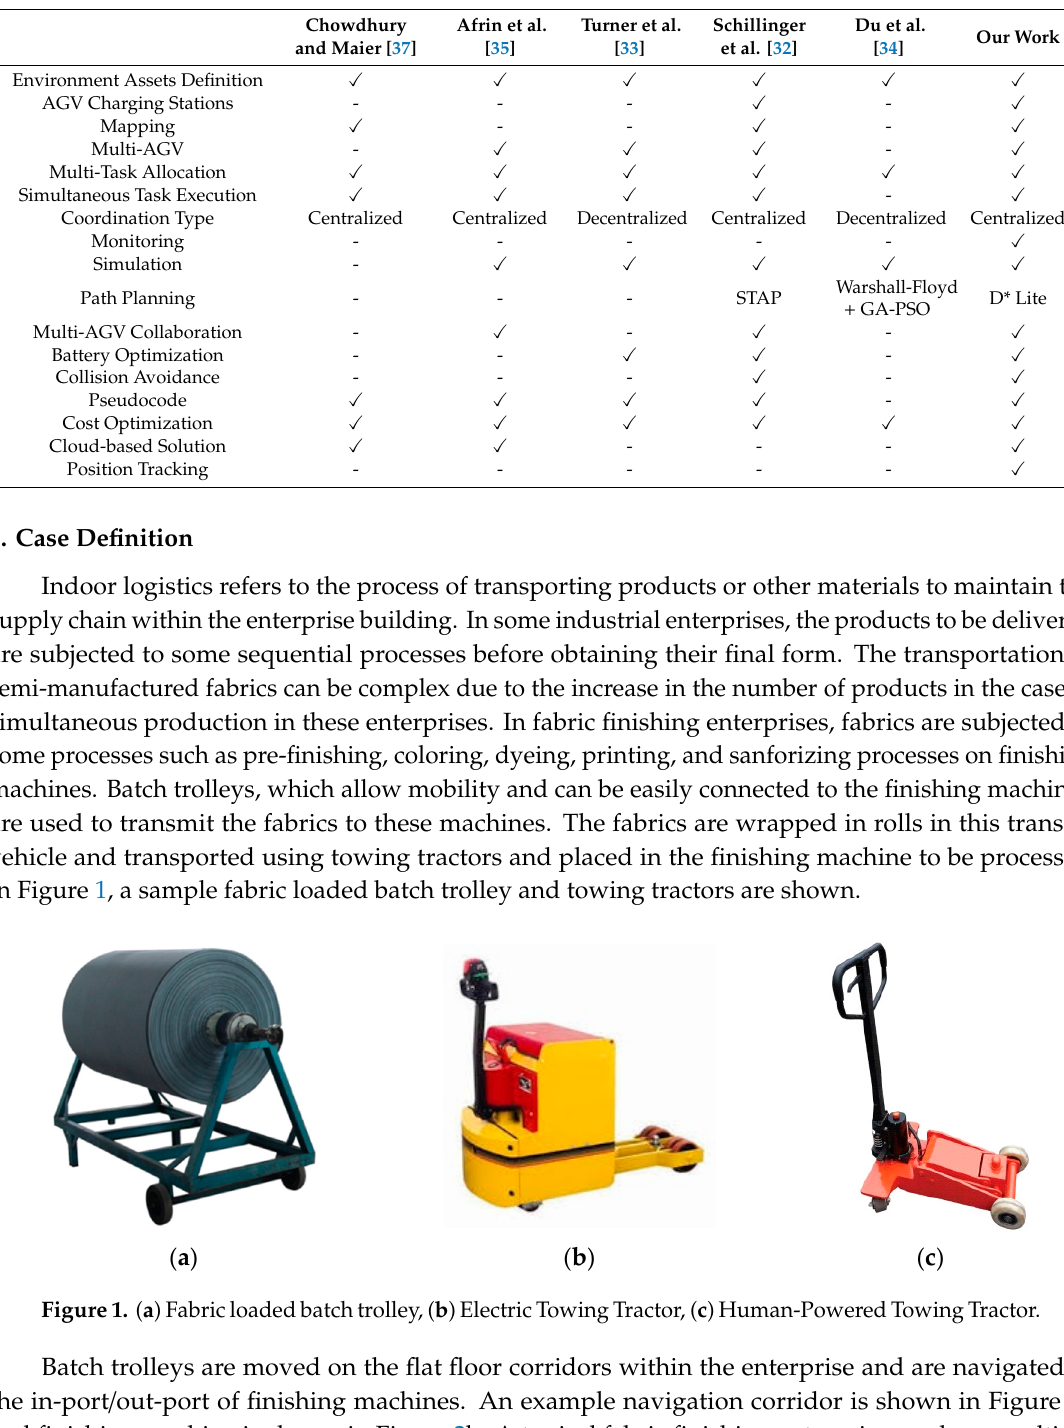
Table 1. Comparison of the developed system in prominent related works.